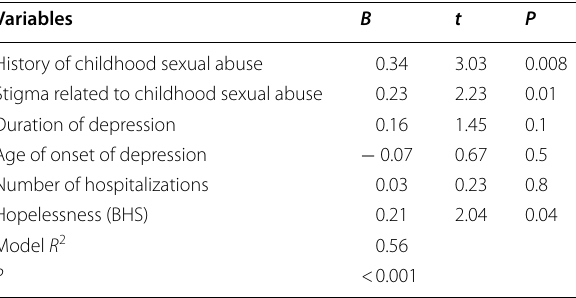
Table 2 Multiple regression analysis for variables predicting the severity of depression (BDI‑II scores) in depressed